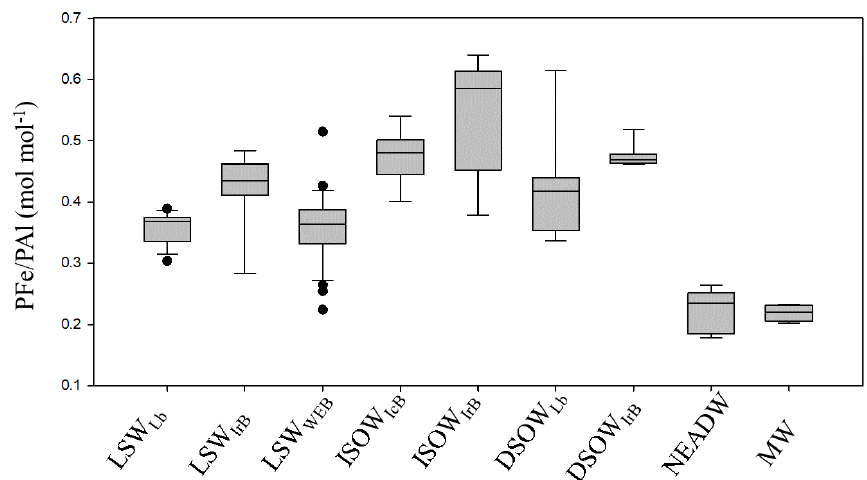
Figure 7. Box and whisker diagram of the PFe / PAl molar ratio in nine water masses sampled along the GA01 section in the North At- lantic Ocean. Water masses are defined in Sect. 3.1 and in Fig. 2. The PFe / PAl median values for each water mass with the biogeo- chemical provinces in subscript were as follows: LSW LB = 0 . 37; LSW IrB = 0 . 44; LSW WEB = 0 . 36; ISOW IcB = 0 . 48; ISOW IrB = 0 . 58; DSOW LB = 0 . 42; DSOW IrB = 0 . 47; NEADW IAP = 0 . 23; MW = 0 . 22molmol − 1 . The difference in PFe / PAl between water masses is sta- tistically significant (Kruskal–Wallis test; p = <0.001 excluding water masses for which we had fewer than five data points for PFe / PAl). Note that the UCC PFe / PAl ratio reported from Taylor and McLennan (1995) is 0.21molmol − 1